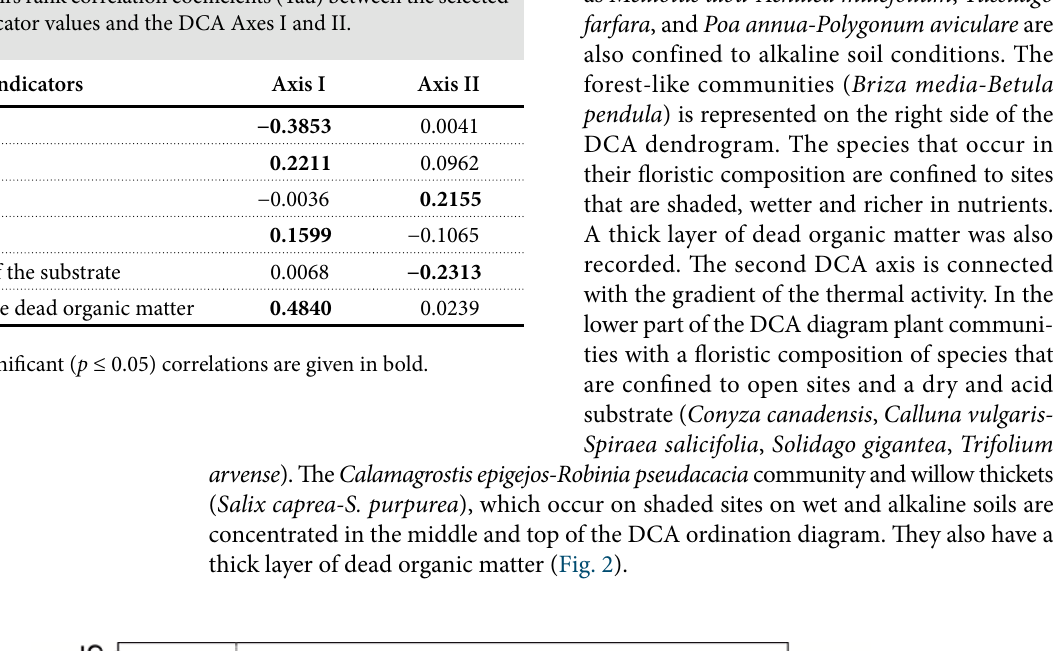
Tab. 3 Kendall’s rank correlation coefficients (Tau) between the selected